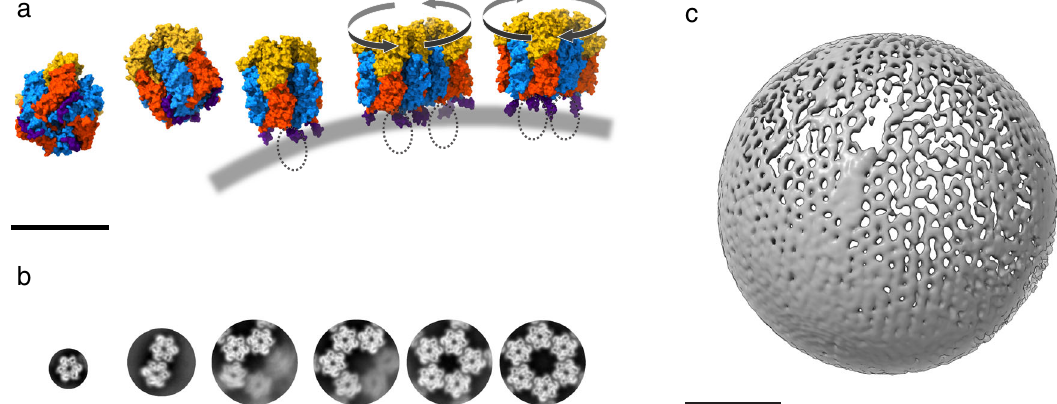
Fig. 5 Capsid-like assembly hypothesis of the immature VACV scaffold in vivo. a Schematic illustration of D13 assembly initiation. D13 exists as individual trimers in the cytoplasm. Once D13 is recruited onto the surface of a viral membrane (depicted by a curved gray line) through an interaction with A17 (depicted as dashed ellipses), the N-terminal helix (purple) is dislocated away from D13 and exposes the base-to-base intertrimer interface. D13 trimers can subsequently dimerize with two distinct intertrimer torsions (clockwise and counterclockwise arrows), inducing curvature. b Gallery of D13 oligomers that are basic building blocks of the honeycomb-shaped lattice. Class averages were generated from electron micrographs of honeycomb-like patches (Supplementary Fig. 1). c Expansion of the honeycomb-like lattice into a spherical scaffold. The cryo-electron tomography reconstruction shows a spherical IV scaffold-like particle (diameter 340 nm) with a typical honeycomb-like lattice. Although the limited resolution precluded detailed modeling of the scaffold, it is likely that additional patterns of oligomers such as pentameric building blocks or different combinations of intertrimer arrangements are required to form the authentic immature VACV scaffold. Scale bars, 10 nm in a , b , and 100 nm in c ,